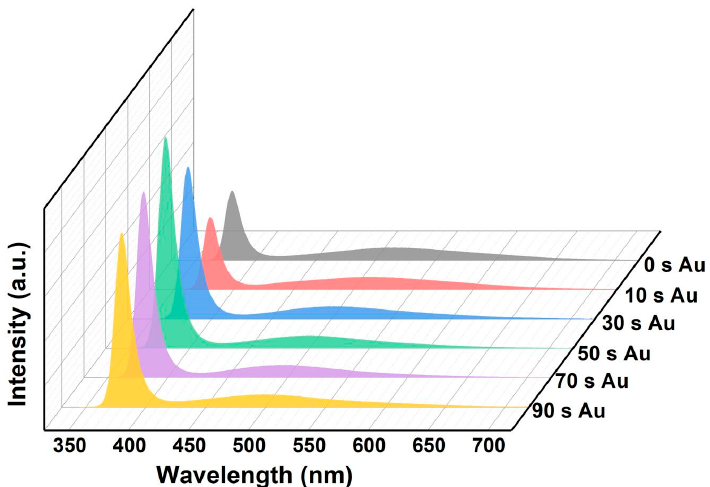
Figure 5. PL spectra of ZnO NRs with different Au sputtering times.